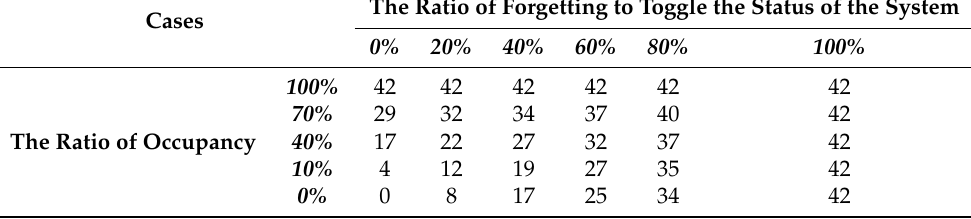
Table 1. The ratio of occupancy and the ratio of forgetting to toggle the status of the system for all the workers in the office.